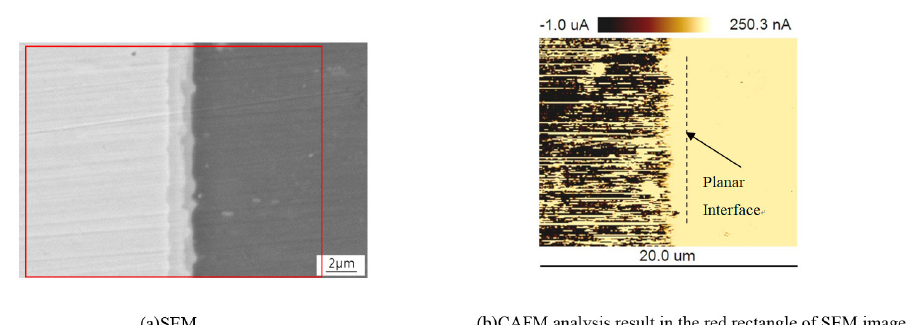
Figure 4. Microstructure and current distribution map of diffusion brazed Cu/Al joint: (a) SEM; (b) CAFM analysis result in the red rectangle of SEM image.